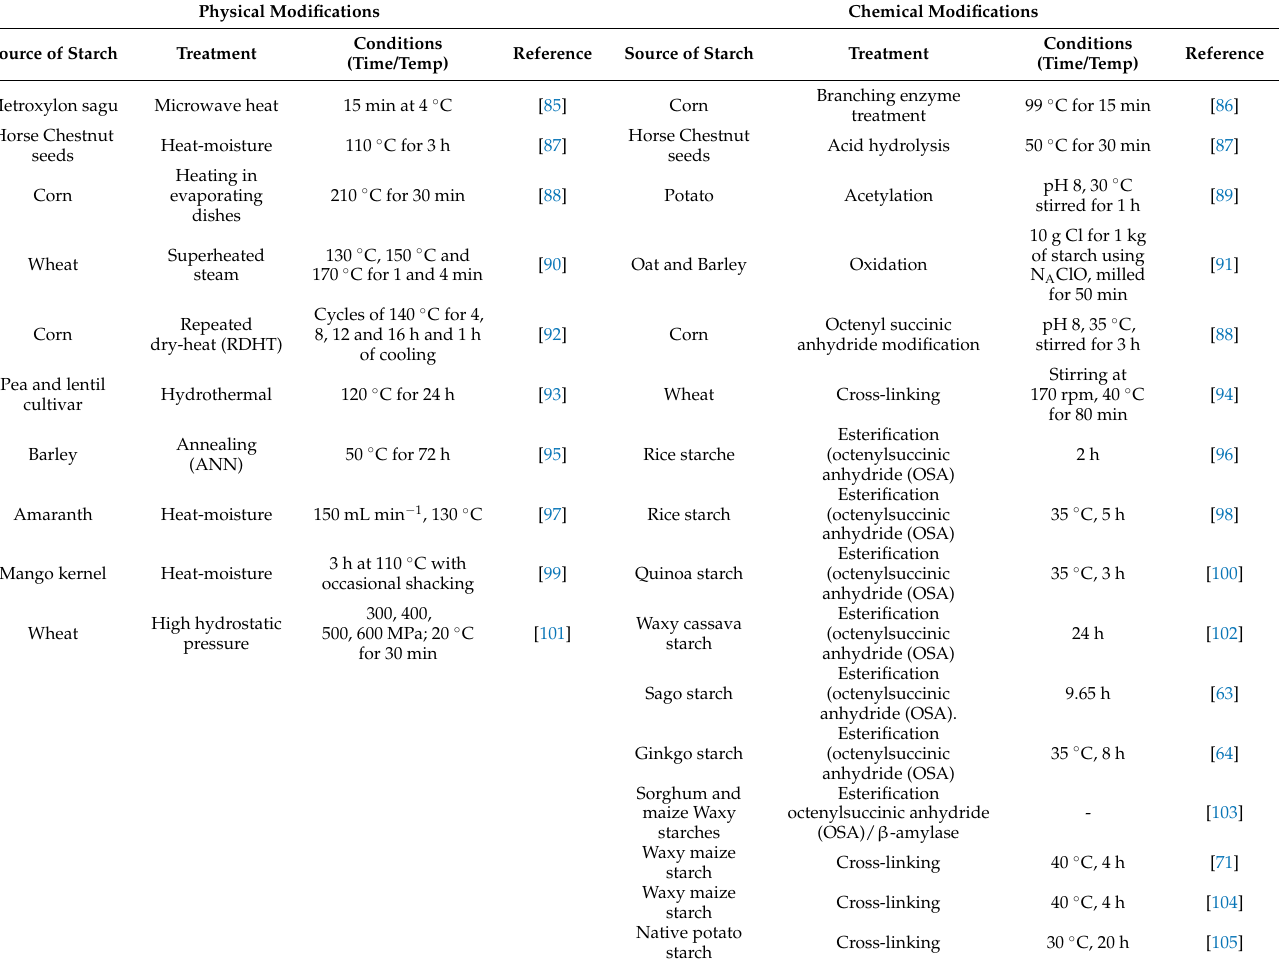
Table 2. Chemical and physical modifications of